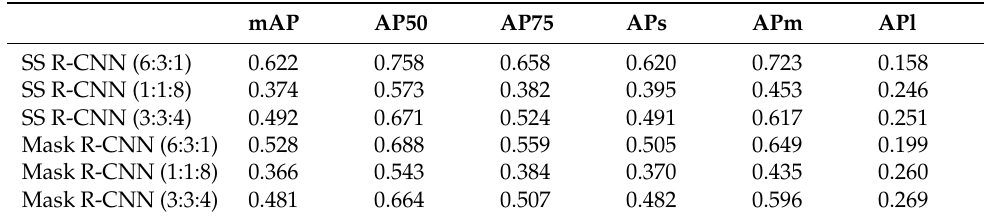
Table 3. Accuracies of SS R-CNN and Mask R-CNN with various ratios of medium ships and large ships. mAP